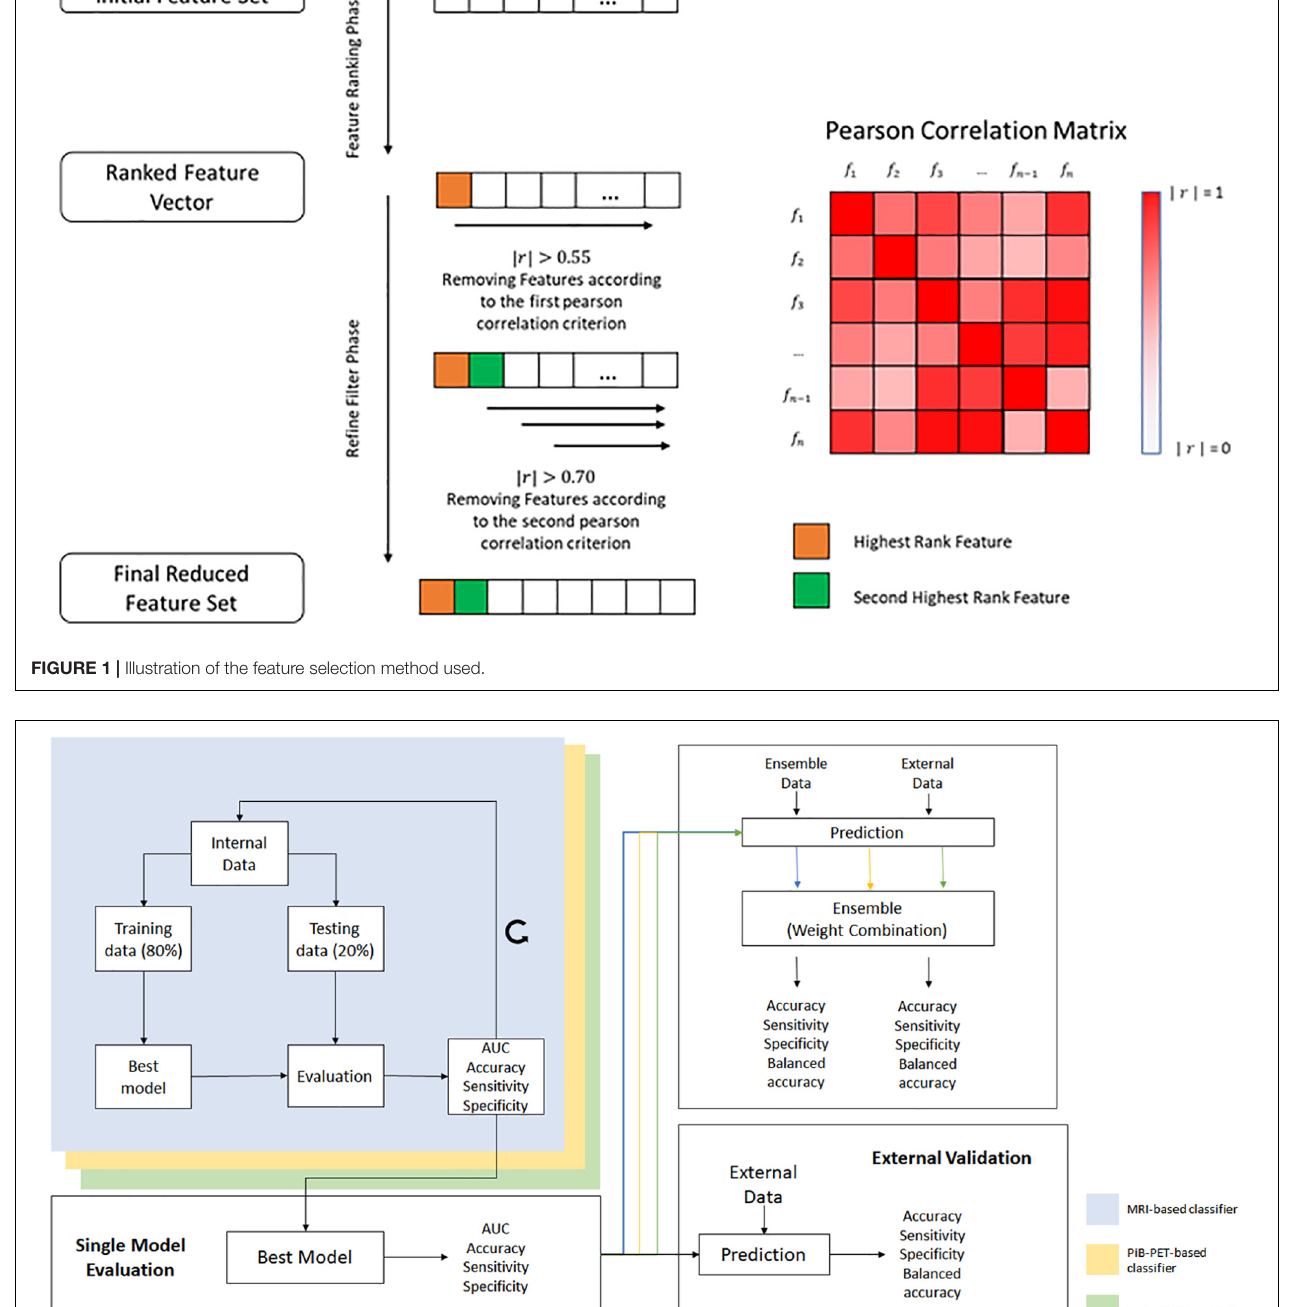
The base classifiers were combined using a weight value between 0 and 1, that was applied to the predicted probability, given from each of the base learning